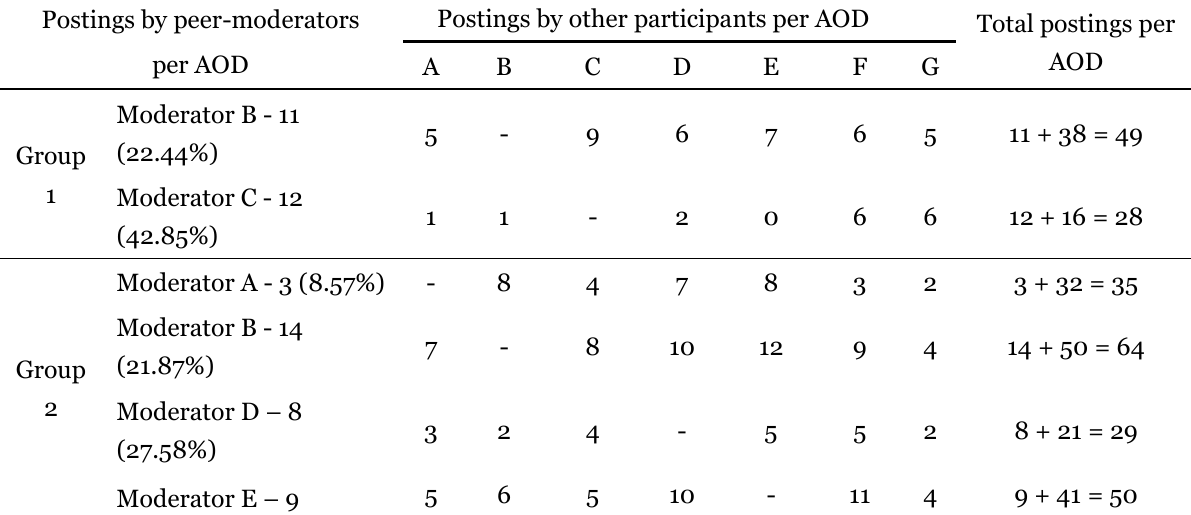
Frequency of Messages per AOD Posted By Peer Moderator and Other Participants Postings by